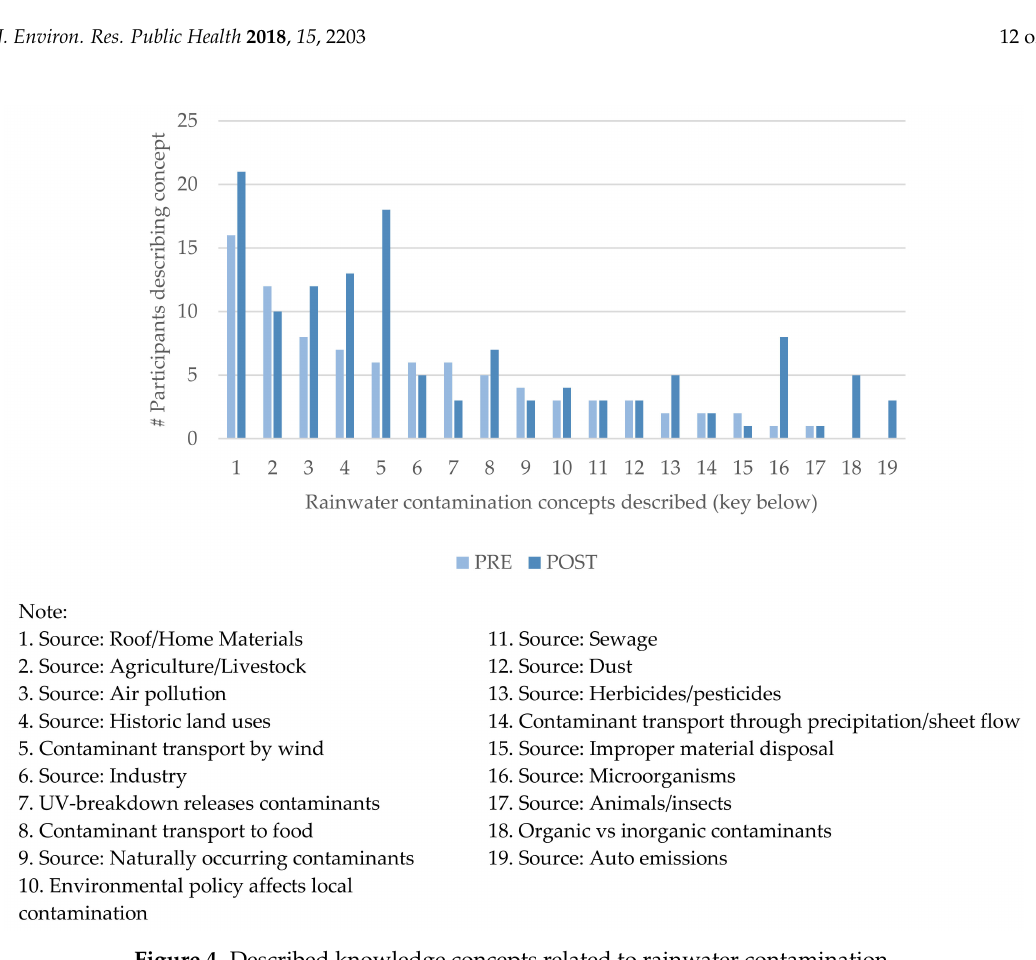
Figure 4. Described knowledge concepts related to rainwater